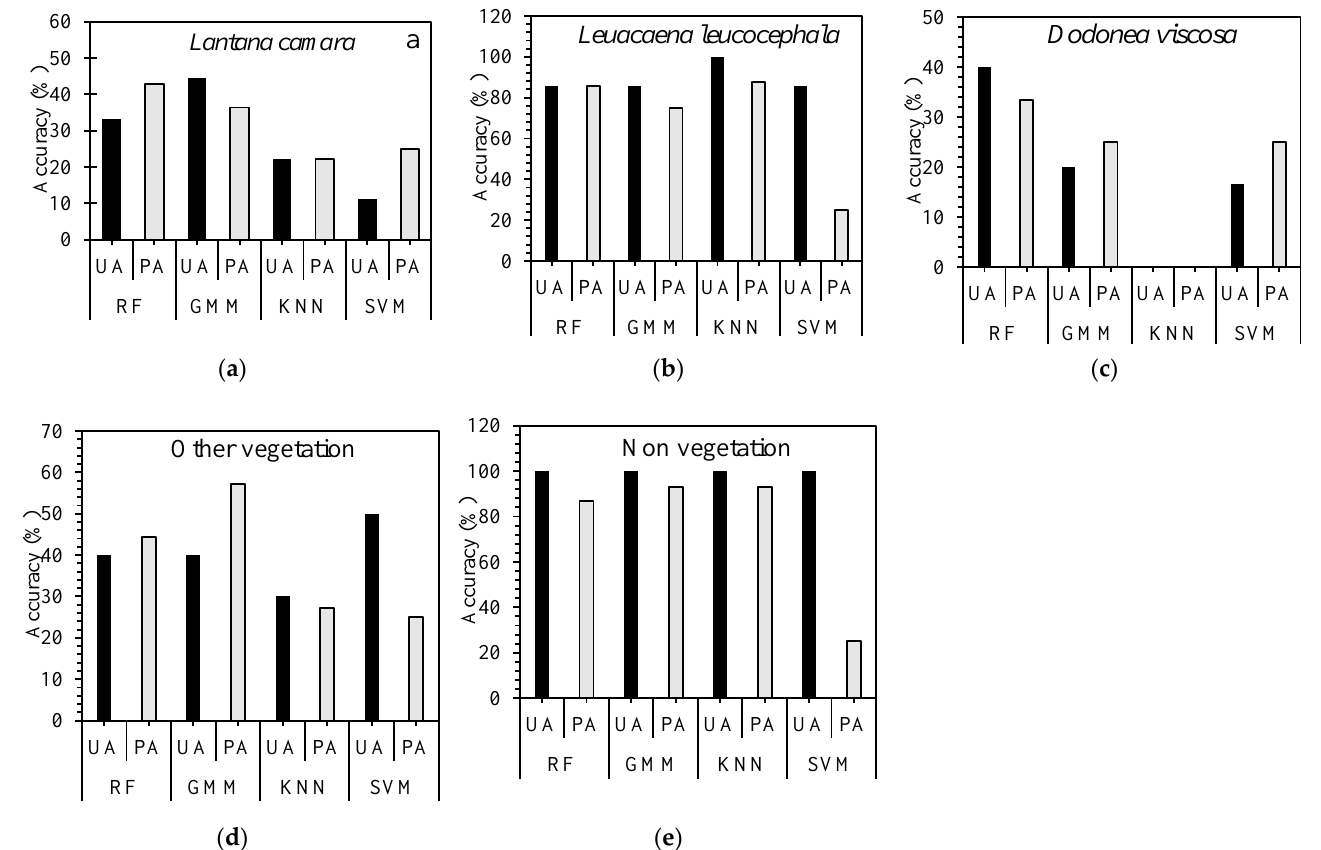
Figure 3. Graphical representation of user accuracy (UA) and producer accuracy (PA) for PlanetScope data with all classes. Lantana camara , ( a ) Leucaena leucocephala , ( b ) Dodonaea viscosa , ( c ) other vegetation, ( d ) and non-vegetation ( e ).